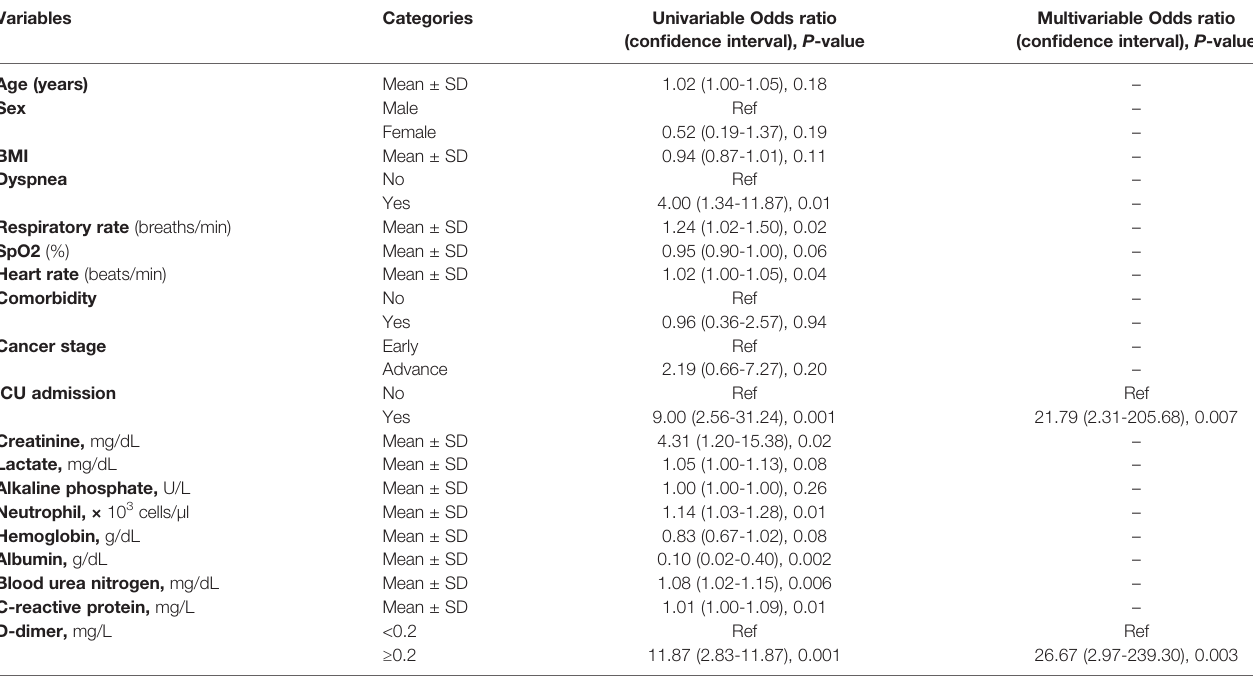
TABLE 5 | Adjusted logistic regression analysis of factors associated with mortality. Variables